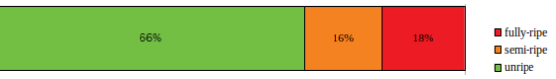
Figure 4. TomatOD dataset object class distribution.